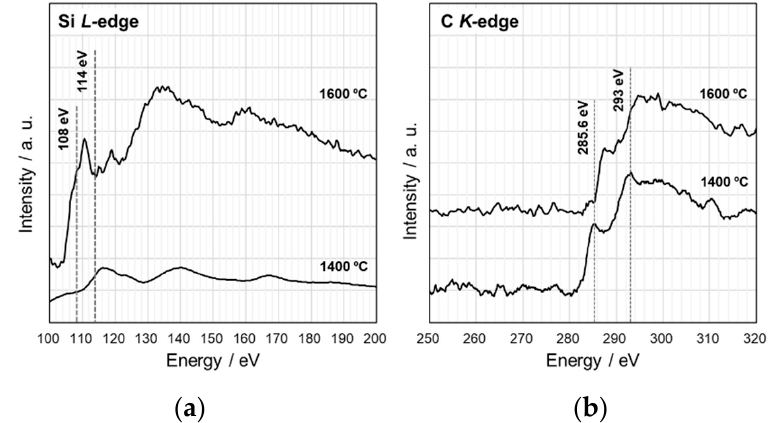
Figure 9. EELS spectra for the SQ-derived S1 after heat treatment at 1400 and 1600 °C. ( a ) Si L-edge and ( b ) C K-edge.